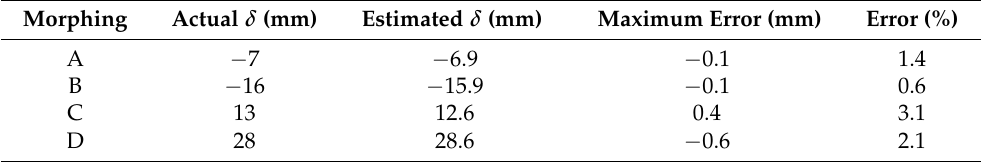
Table 6. Model estimated deflections of the wing during bending due to arbitrary morphing A to D.